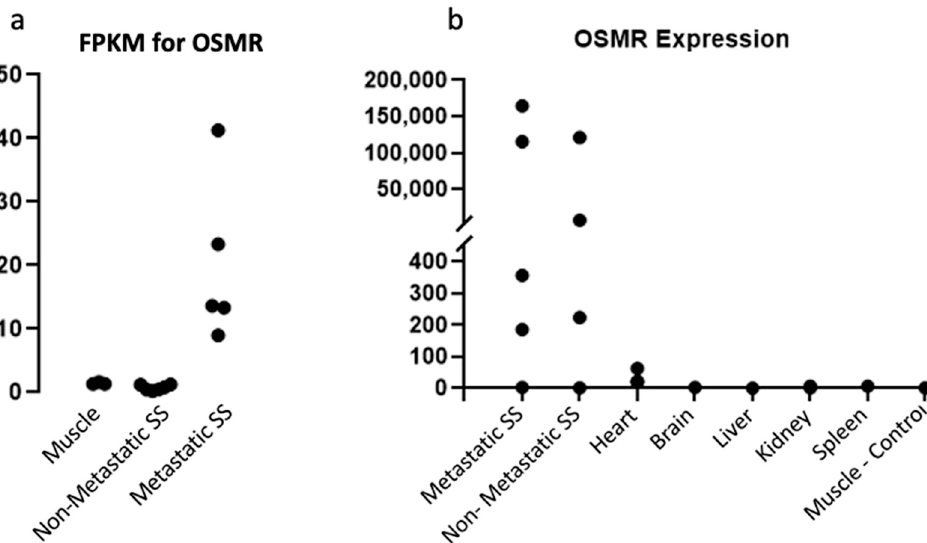
Figure 1. OSMR Expression is Independent of Metastatic Status. ( a ) RNAseq data of metastatic and non-metastatic tumors as well as normal muscle tissue shows a correlation between metastatic status and OSMR expression. ( b ) RTqPCR shows no such correlation and that both states can have high or low OSMR expression. Low expression of OSMR was also noted in the heart.